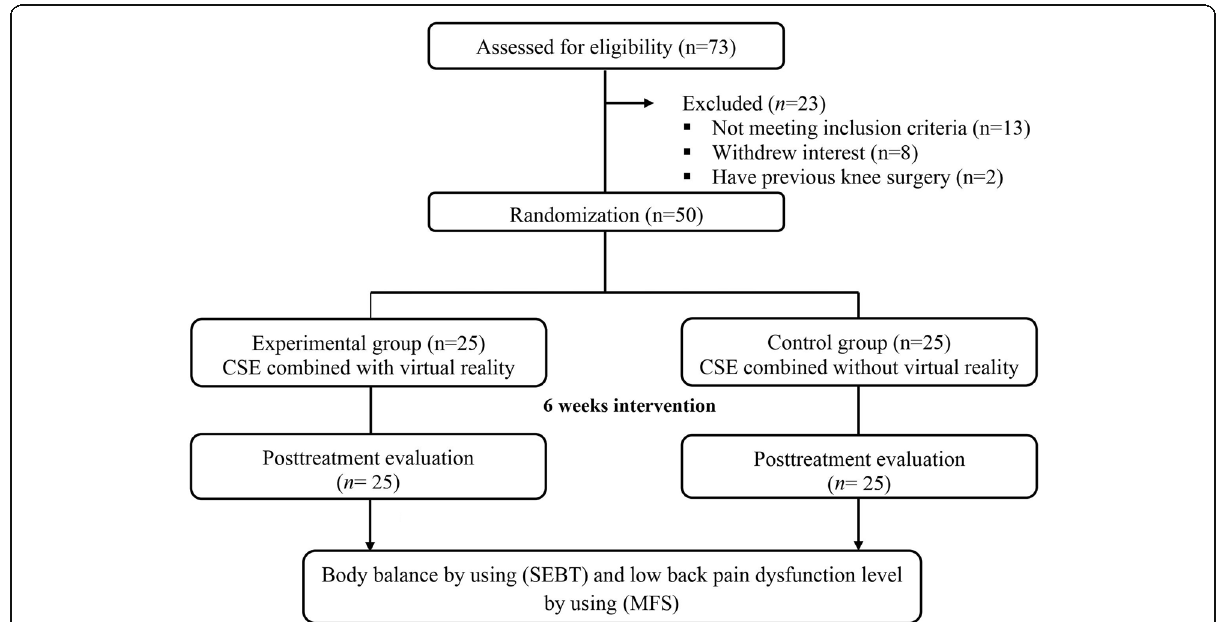
Fig. 1 Flow diagram of participant progress through the study. CSE, core stability exercises; SEBT, star excursion balance test; MFS, Micheli Functional